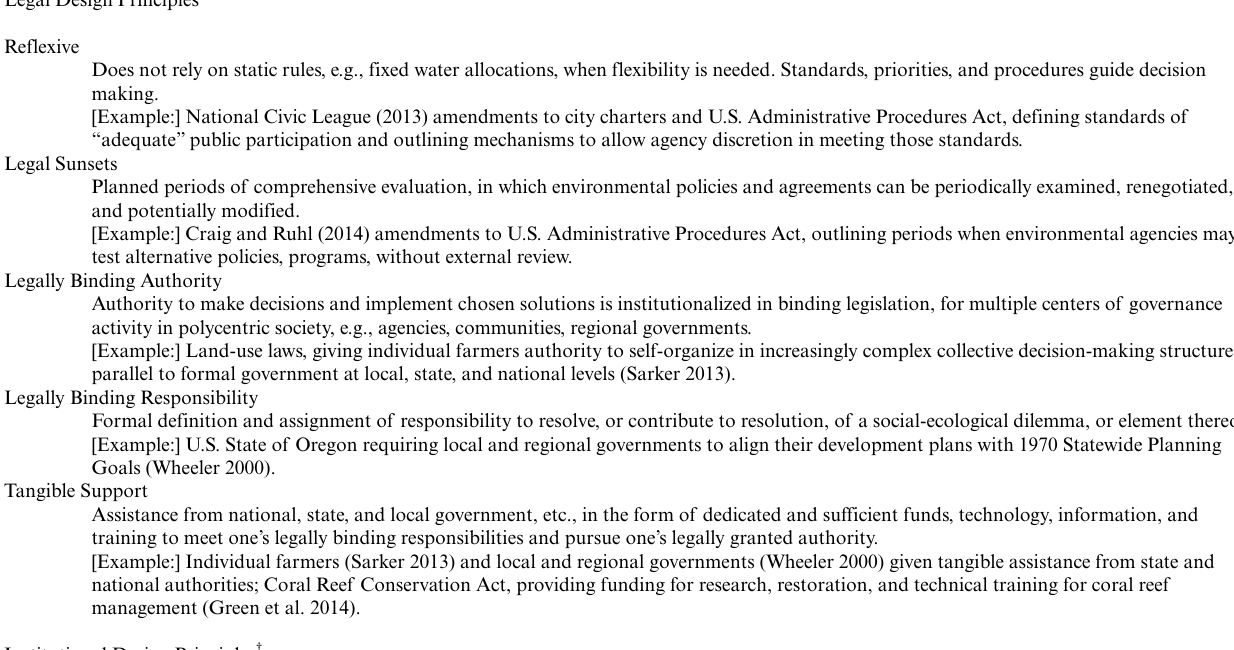
Table 1 . Candidate legal and institutional design principles of adaptive